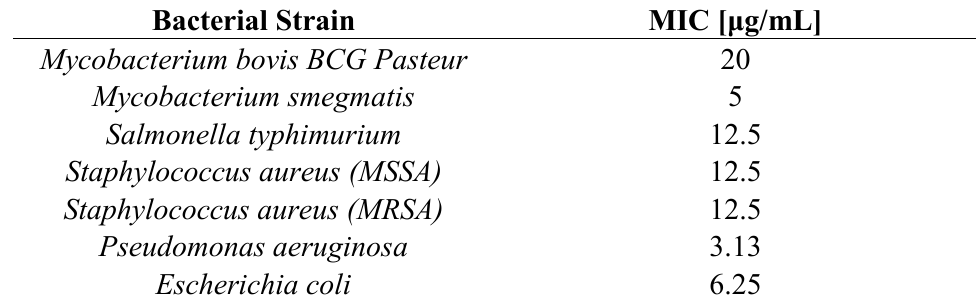
Table 1. Minimum inhibitory concentration (MIC) of SBC3 against different bacterial